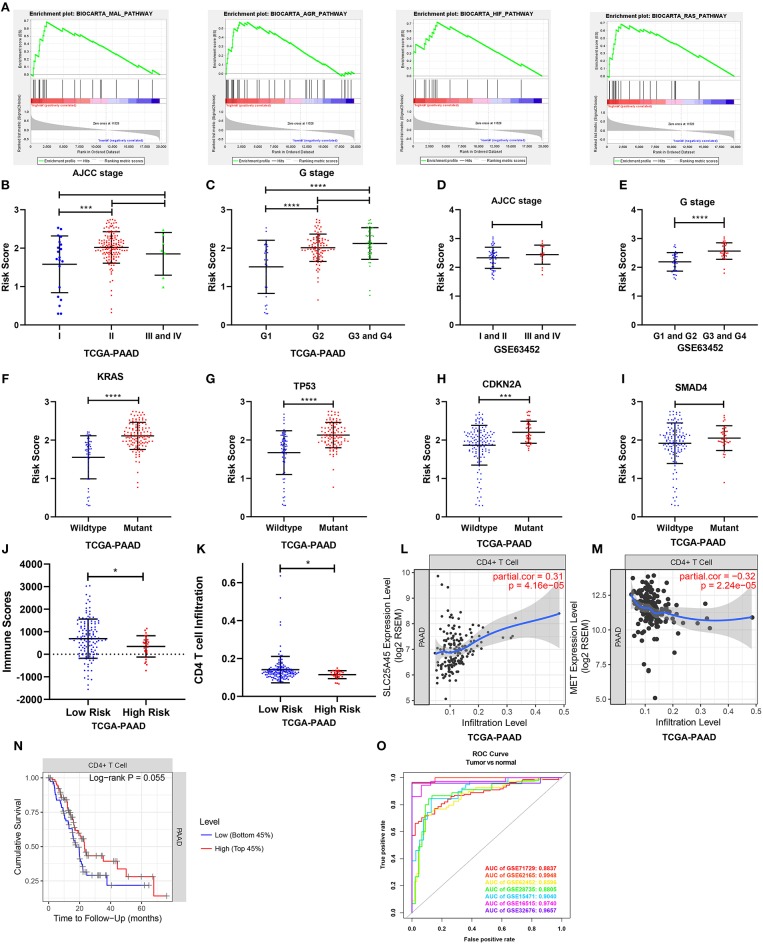
Gene set enrichment analysis and the clinical- and tumor immunity relevance of the nine-gene signature. (A) Top 4 oncological signatures significantly enriched in the high-risk group identified by gene set enrichment analysis. (B,D) Show the distribution of the risk score in different AJCC stage in TCGA and GSE63452 datasets. (C,E) Show the distribution of the risk score in different grade in TCGA and GSE63452 datasets. (F–I) Show the distribution of the risk score in different mutation status of KRAS, TP53, CDKN2A, and SMAD4 in TCGA dataset. (J) Show the distribution of the immune score in high risk and low risk group in TCGA datasets. Immune scores were calculated with the ESTIMATE algorithm (https://bioinformatics.mdanderson.org/public-software/estimate/). (K) Shows the CD4 T cell infiltration level in high risk and low risk group in TCGA datasets. The abundances of CD4+ T cells were estimated using the TIMER algorithm (https://cistrome.shinyapps.io/timer/). (L,M) Show the correlation of SLC25A45 and MET expression with immune infiltration level in pancreatic cancer. (O) The ROC curves of the risk score differentiating pancreatic cancer from normal tissues in the seven GEO datasets. *P < 0.05, ***P < 0.001, ****P < 0.0001.